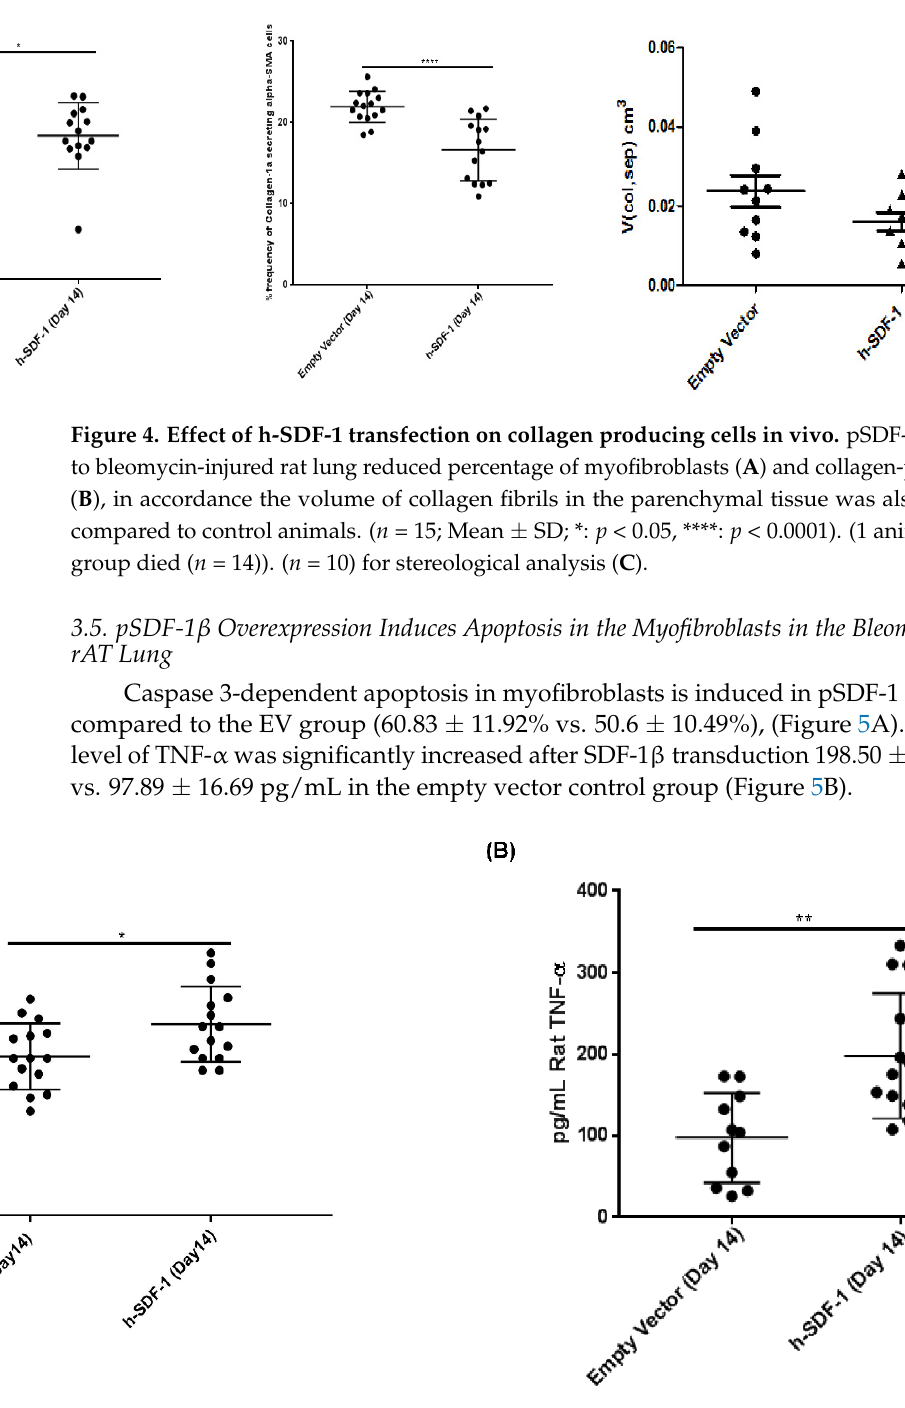
Figure 5. h-SDF-1 overexpression induces apoptosis on myofibroblasts in vivo. pSDF-1 gene transfer to bleomycin-injured rat lung induces apoptosis of myofibroblasts. Increased caspase-3- positive cells after pSDF-1 treatment ( A ), SDF-1 induces apoptosis by TNF- α -mediated pathway; increased TNF- α in rat lung homogenate after pSDF-1 treatment ( B ). *: p < 0.05, **: p <